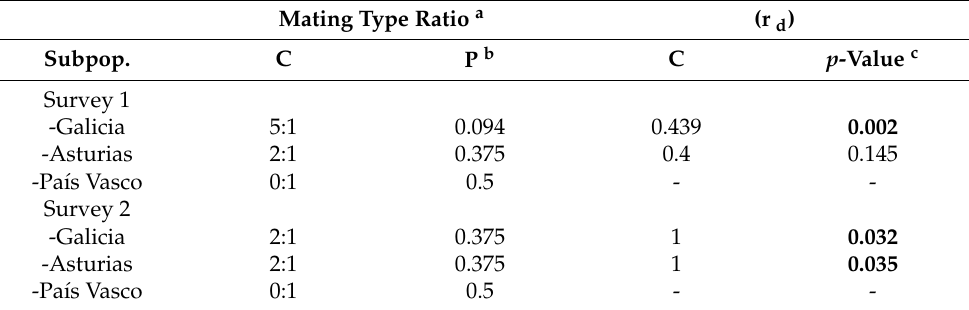
Table 3. Standardized index of association (r d ) and mating type in Spanish subpopulations of Fusarium circinatum defined in a temporal scale and by geographic origin, calculated on the clone- corrected (C)